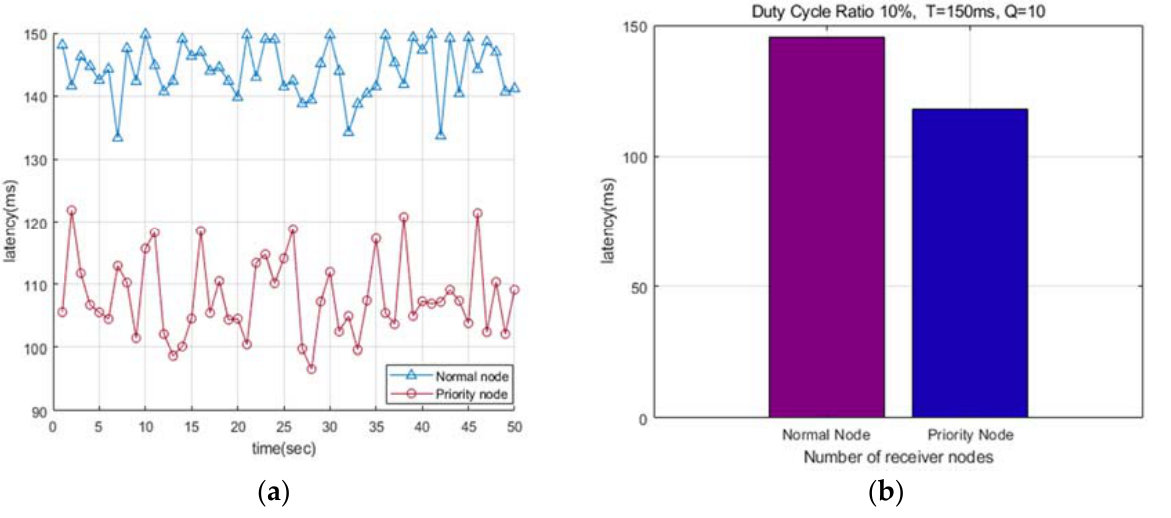
Figure 6. Comparison of latency between Duty Cycle MAC and Pre-emption MAC: ( a ) Comparison of latency over time; ( b ) Comparison of average delay.